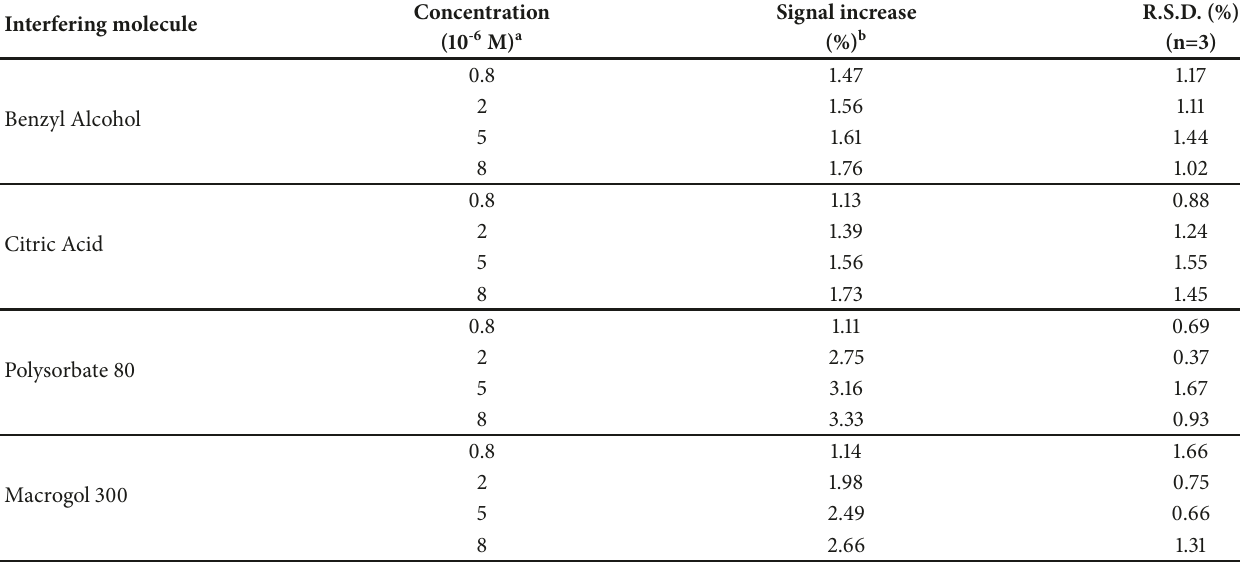
Table 1: Effect of excipients on the differential pulse voltammetric response at the MIP/GCE